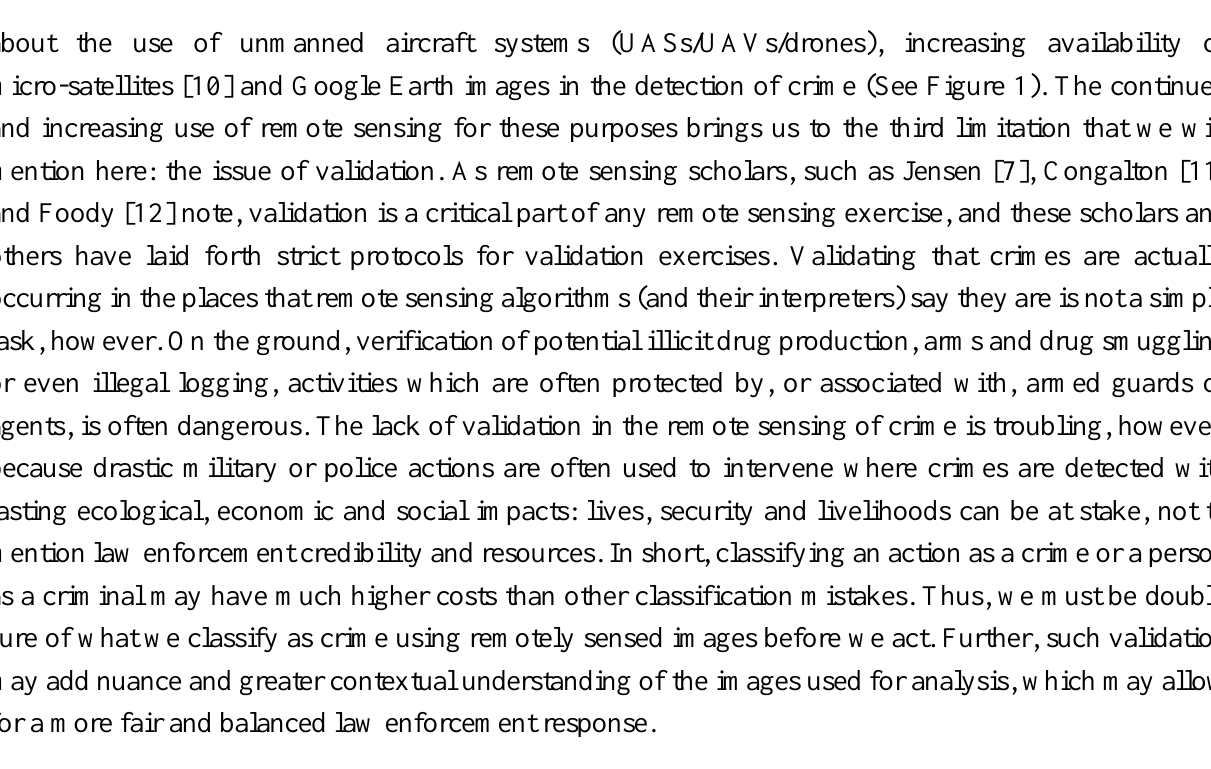
Figure 1. Results from Google Scholar searches for “crime” and remote sensing terms from 1999 to